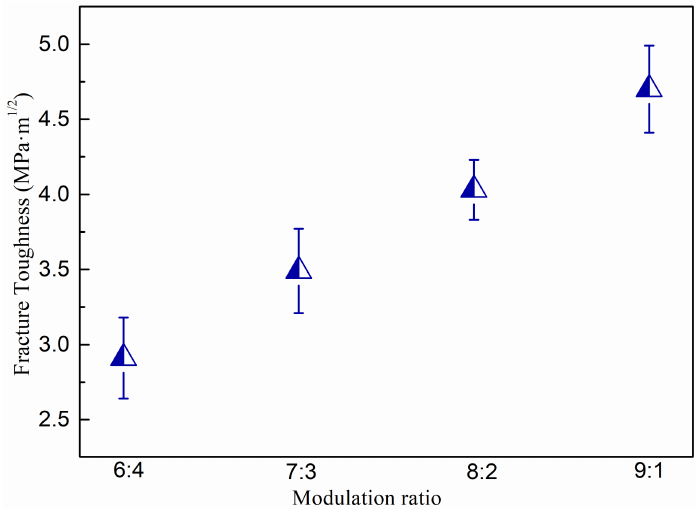
Figure 6. Toughness of Mo/VC multilayers with varied modulation ratios from 6:4 to 9:1.